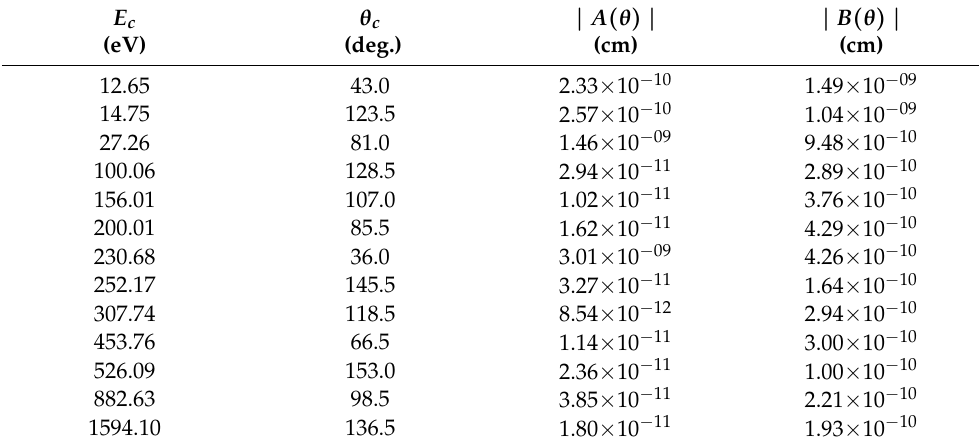
Table 7. The energy and angular positions and the values of direct and spin-flip scattering amplitudes of the deep minima (DM) in the DCS for elastic e − − Pt scattering.